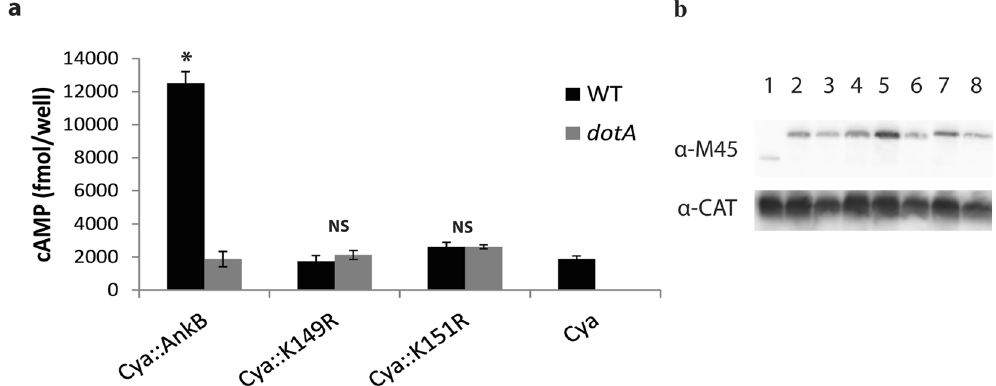
Figure 7. The putative di-lysine motif in the C-terminus of AnkB-Paris is essential for translocation by the Dot/ Icm system. ( a ) Translocation of AnkB-Paris into U937 cells at 2 hours post-infection by WT or dotA mutant bacteria expressing either Cya (negative control) or the indicated Cya::AnkB-Paris fusions. Data represent the mean cAMP concentration of 3 wells ( ± 1 SD). * p < 0.005 compared to dotA harboring Cya::AnkB-Paris. ( b ) Proteins derived from 1 × 10 8 bacteria were loaded onto an SDS-PAGE gel and expression of fusion constructs was detected by Western blot using an antibody to the M45 epitope present in all Cya fusions. Blots were re- probed with anti-CAT antibodies. Lanes 1: WT Cya, 2: dotA Cya-AnkB-Paris K 151 R, 3: WT Cya-AnkB-Paris K 151 R, 4: dotA Cya-AnkB-Paris K 151 R, 5: dotA Cya-AnkB-Paris K 149 R, 6: WT Cya-AnkB-Paris K 149 R, 7: dotA Cya-AnkB-Paris, 8: WT